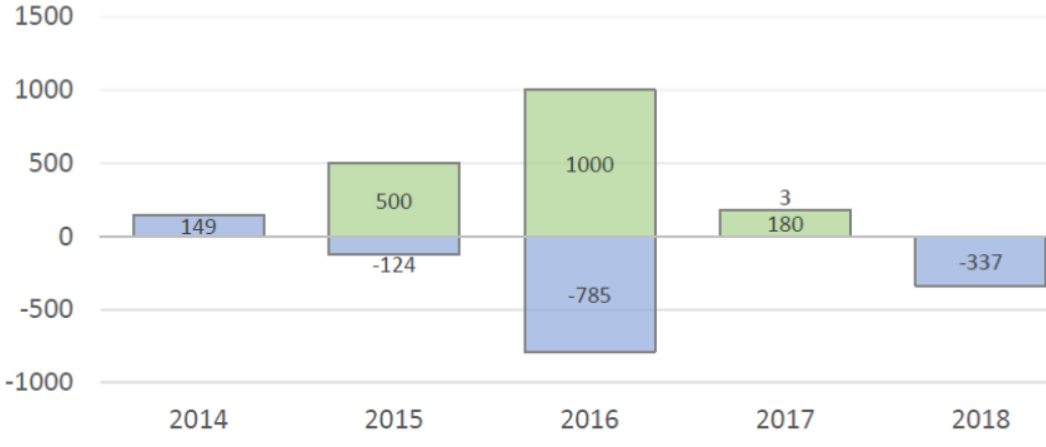
Figure 6: Outflow of profit share and movement on account SKANSKA's retained earnings (CZK million), (source: Annual report of SKANSKA 2014-2018, data processed by the authors) The retained earnings account of SKANSKA decreased from 7 billion to 2.66 billion CZK over five years - see Figure 7. This is due to large dividend drawdowns in 2015 and 2016. In 2016, the company's dividends represent almost 39% of the total dividends in construction sector outflow abroad).